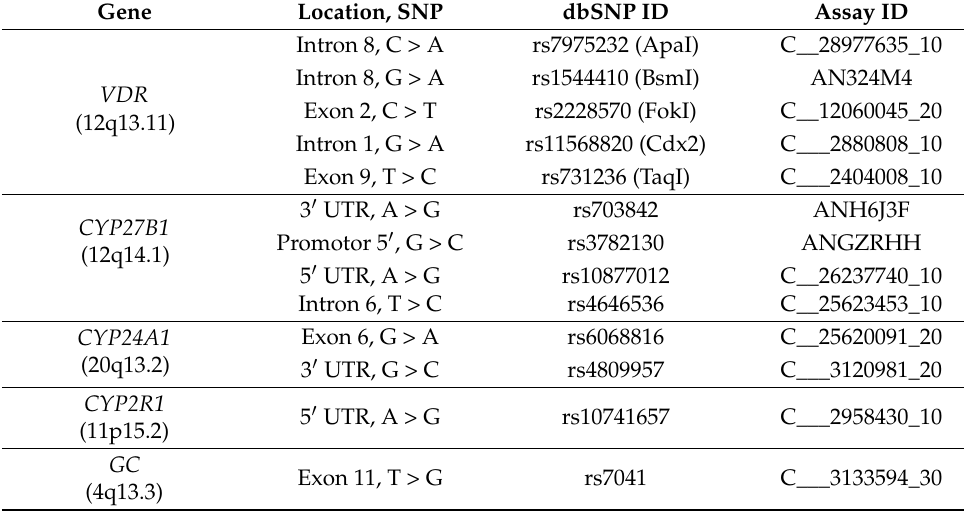
Table 1. Gene polymorphisms and TaqMan